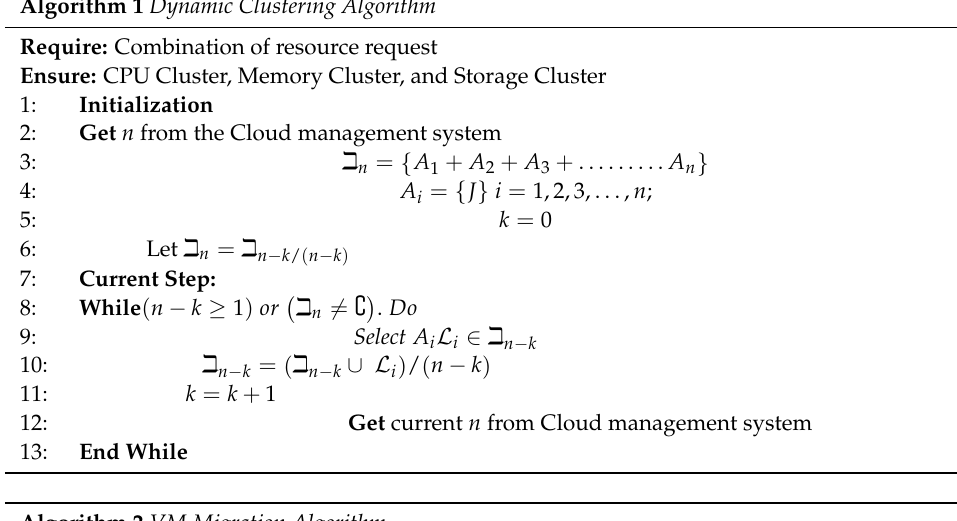
Algorithm 2 VM Migration